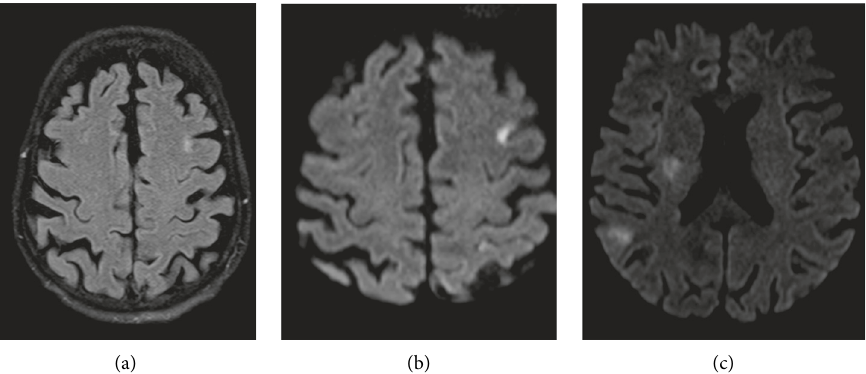
Figure 1: Bilateral ischemic lesions: at the left cortical frontal lobe in FLAIR and diffusion hypersignal (a, b) and in the right parietal and lenticular in diffusion hypersignal